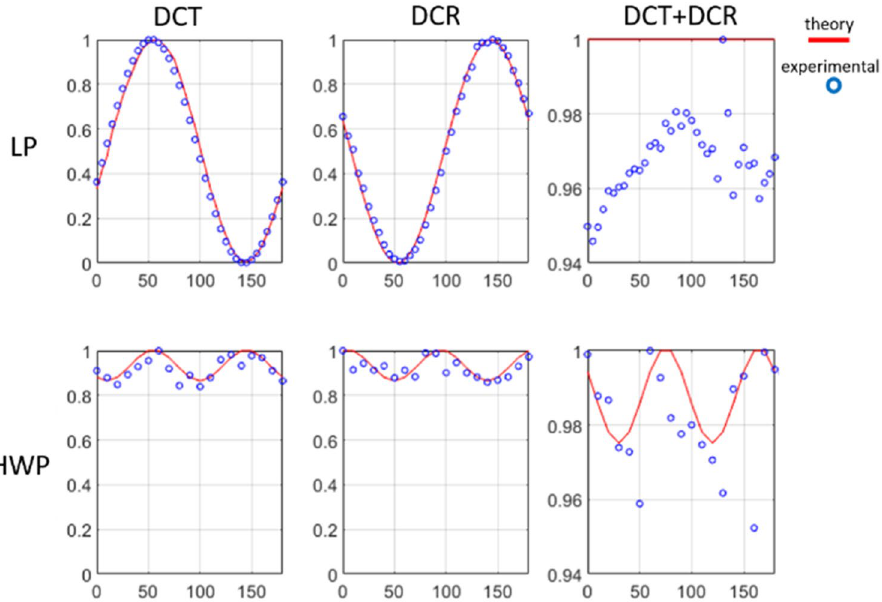
Figure 2. Calibration steps using LP and HWP drawn for detected normalized intensity signal versus azimuthal angle compared to the related theoretical expected curves. The red line and the points plots correspond to the theoretical and experimental data, respectively.